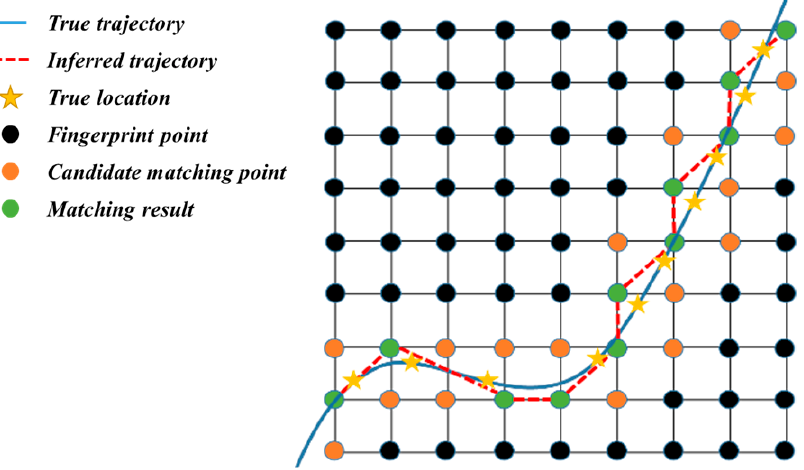
Figure 1. The schematic of wireless device positioning and tracking based on the indoor fingerprint map.